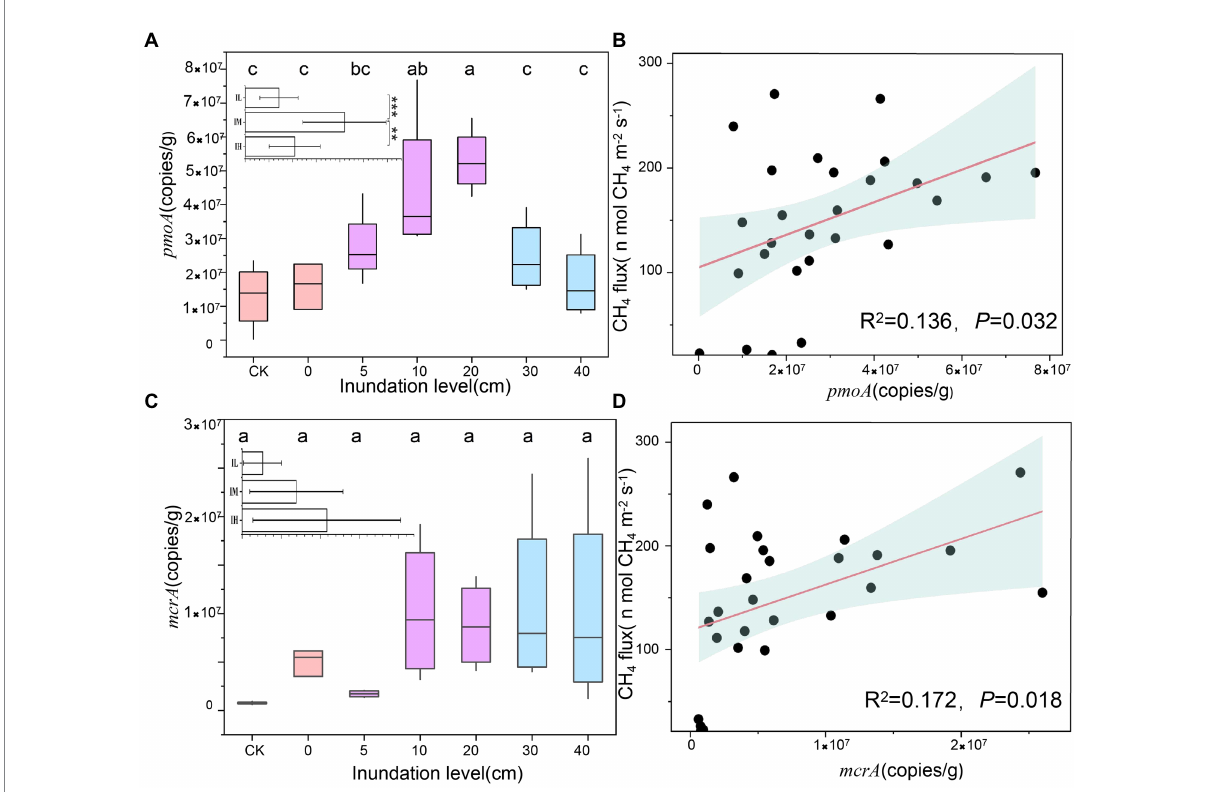
FIGURE 2 Variations in gene copies at different inundation depth and its relationship with CH 4 . (A) Variations in pmoA gene copies at different inundation depths (means ± SE, n = 27). In insets, inundation levels in soil were subjected to the three treatments: Soils were exposed to low inundation (IL), moderate inundation (IM) and high inundation (IH), IL ( n = 7), IM ( n = 12), IH ( n = 8), one-way analysis of variance (ANOVA) of the three groups was performed. (B) Relationships between pmoA gene copies and CH 4 , The pink lines are fitted regressions, and the light blue-shaded areas around the regression lines are 95% confidence. (C) Variations in mcrA gene copies at different inundation levels (means ± SE, n = 27). (D) Relationships between mcrA gene copies and CH 4 flux. Values with superscript letters a, b, c and are significantly different across columns ( p < 0.05).